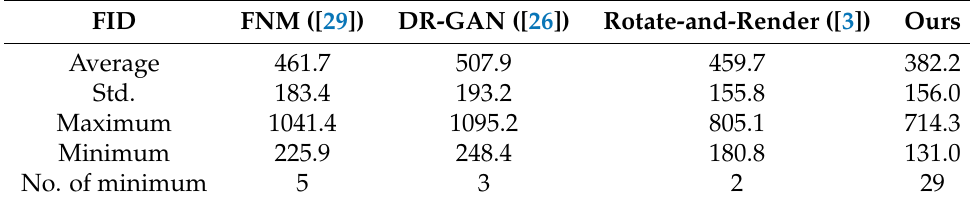
Table 1. Comparison of FID values between the existing models. FID FNM ([29]) DR-GAN ([26]) Rotate-and-Render ([3]) Ours Average